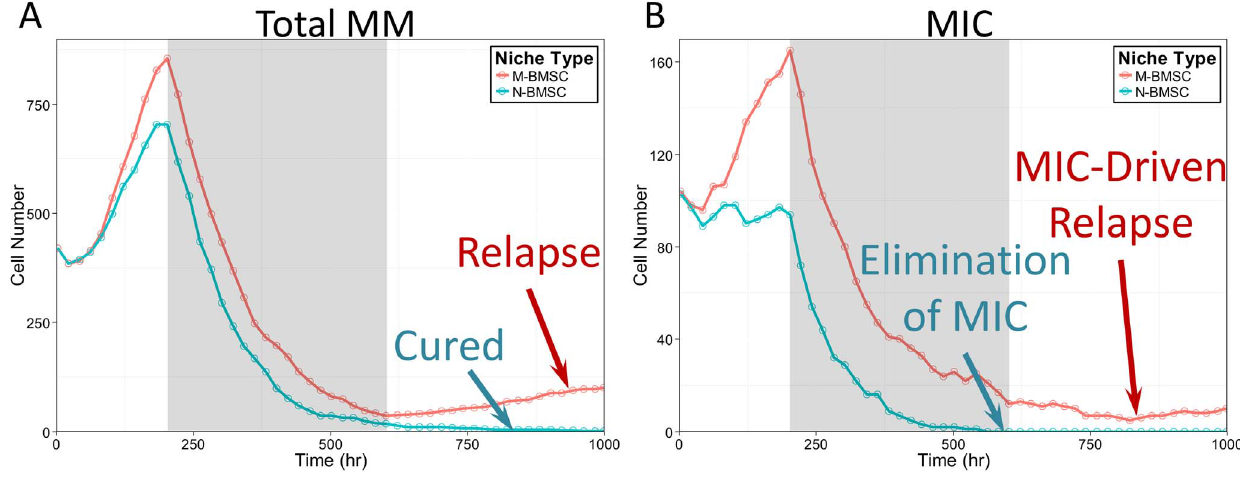
Figure 5. MIC-driven myeloma relapse after cytotoxic chemotherapy cycle. (A) The growing trends of tumor cells under MBMSC (red line) vs. NBMSC (blue) environments under drug treatments. (B) The growing trends of MICs under MBMSC (red line) vs. NBMSC (blue lines) environments under drug treatments. Drug treatment periods were highlighted with gray shade.